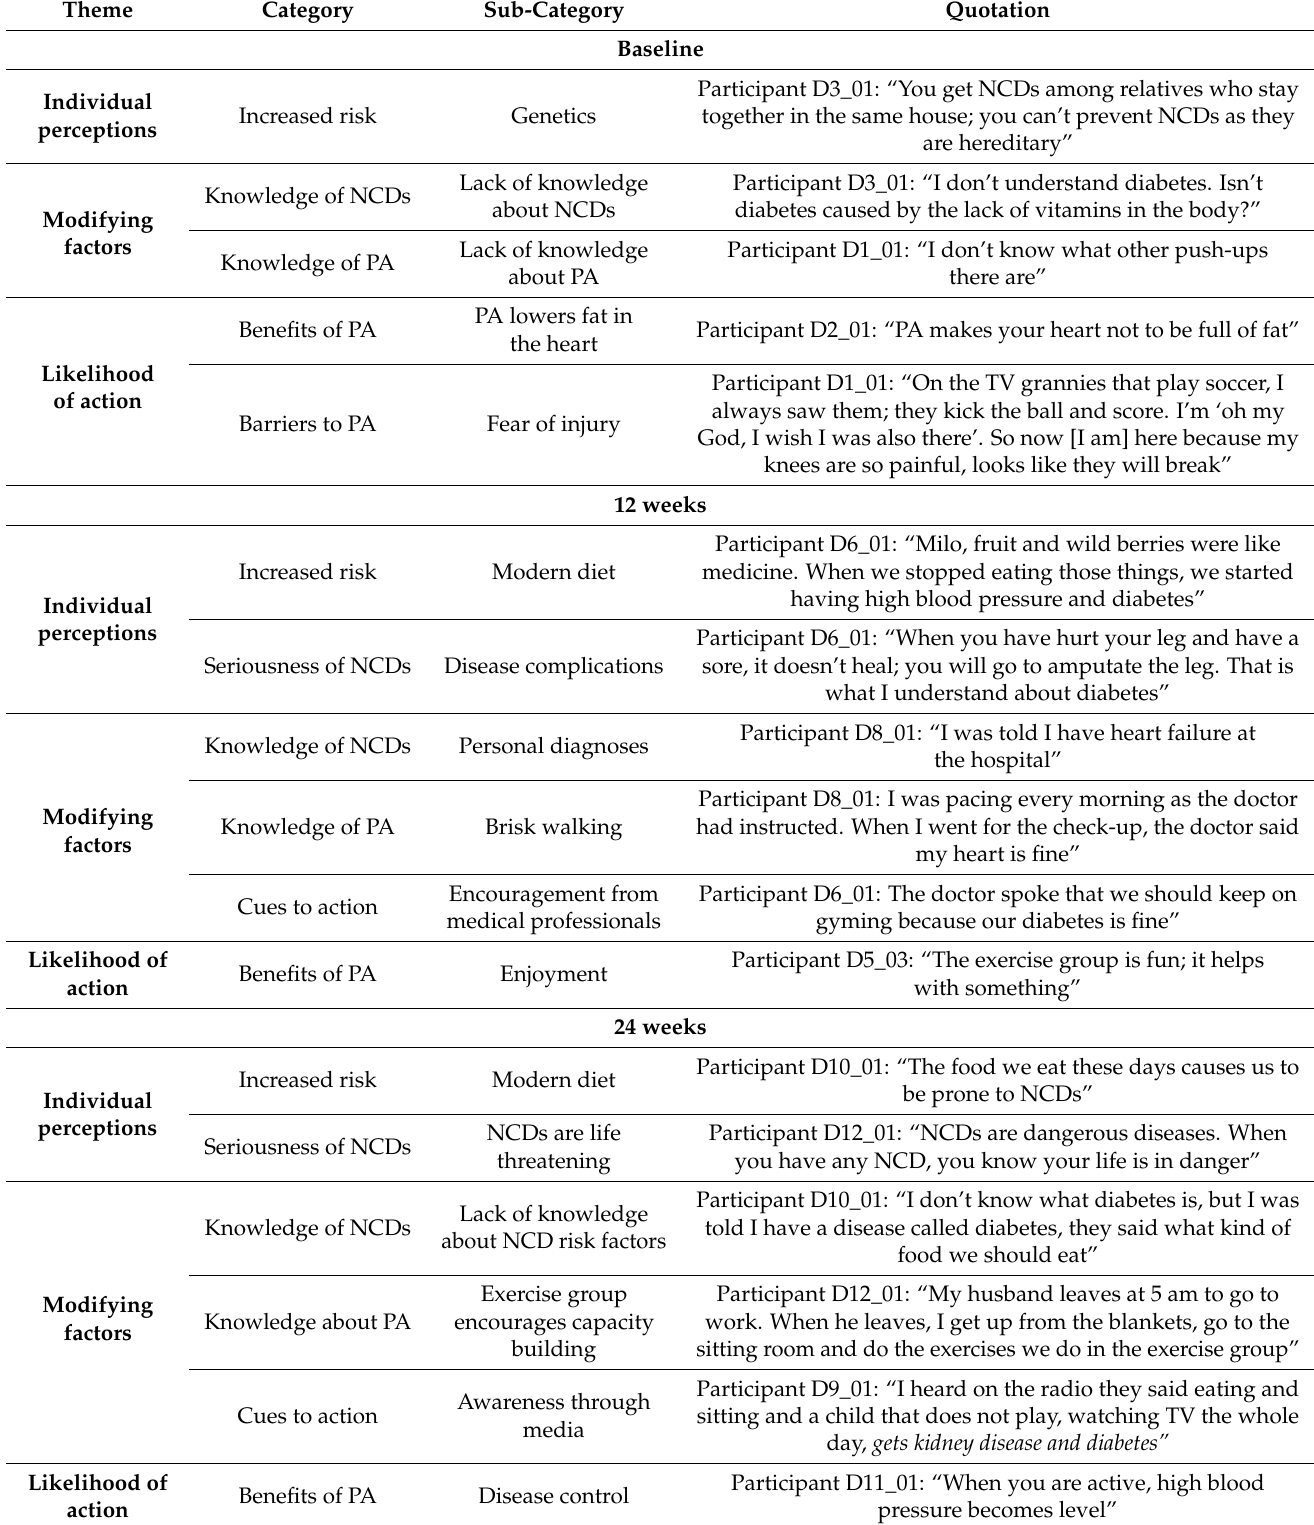
Table 2. Qualitative